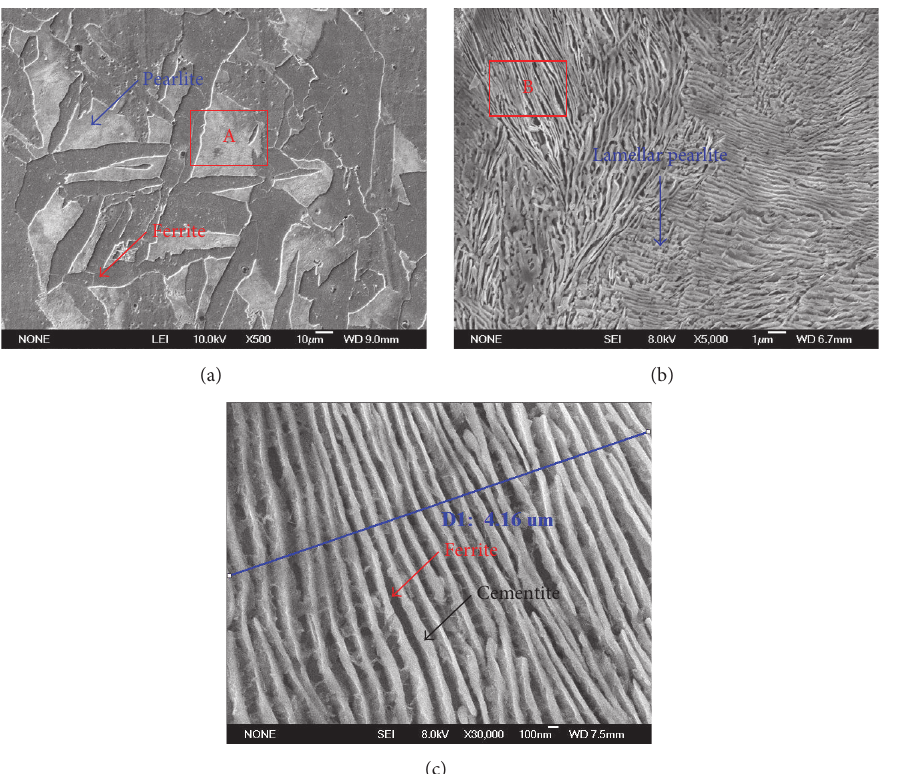
Figure 2: Typical FE-SEM micrographs of the cast 1045 carbon steel prepared by the aluminothermic reaction casting ((b) is the higher magnification of the A region in (a); (c) is the higher magnification of the 𝐵 region in (b)).